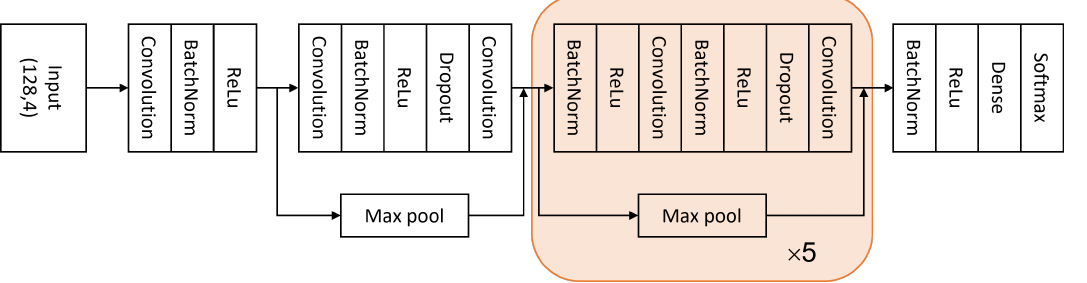
Figure 8. Architecture of deep learning